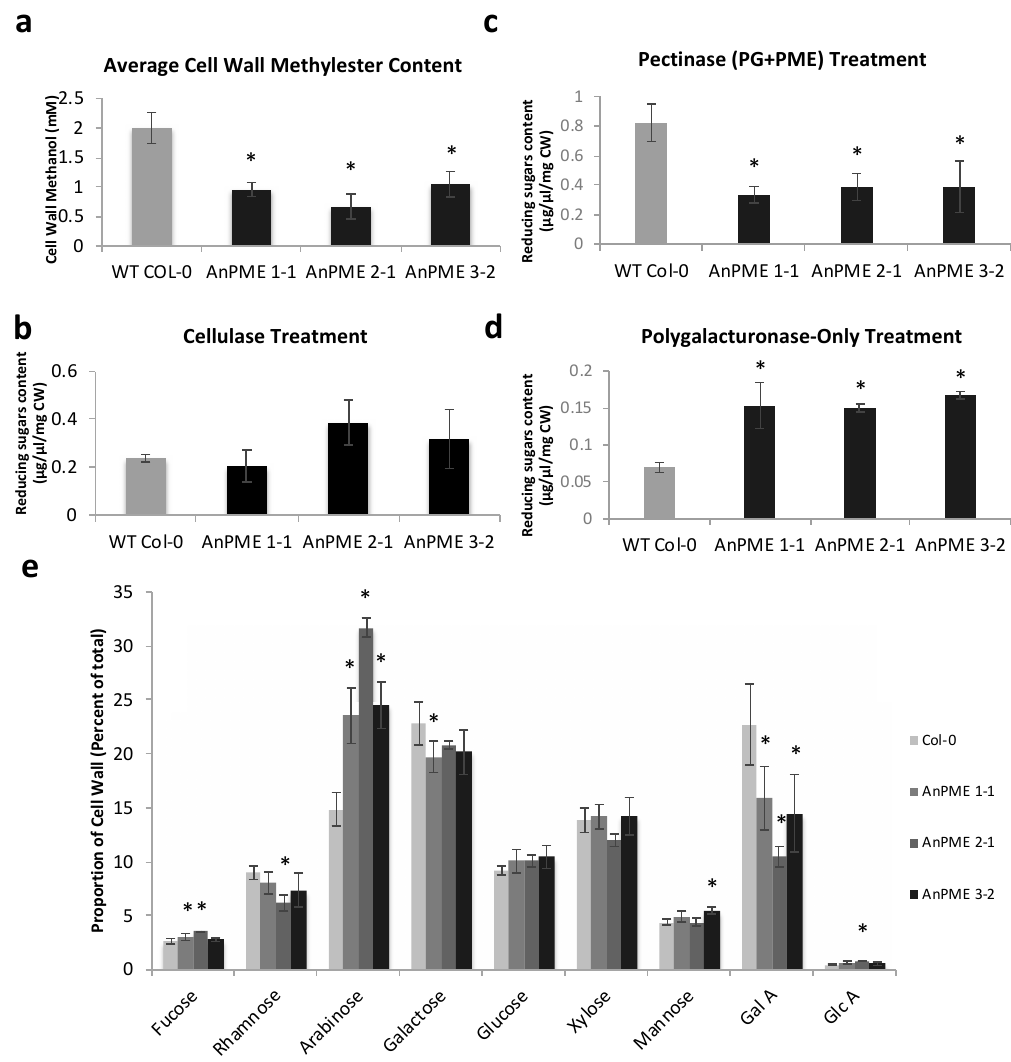
Figure 3. CW characterization and comparison between Col-0 and AnPME. ( a ) Methylester content in WT Col-0 and AnPME cell walls; ( b ) Amount of reducing sugars released into solution after treatment of cell wall with cellulase / cellobiase solution; ( c ) Amount of reducing sugars released into solution after treatment of cell wall with polygalacturonase / pectin methylesterase solution; ( d ) Amount of reducing sugars released into solution after treatment of cell wall with polygalacturonase; ( e ) Monosaccharide composition of cell walls. Error bars represent standard deviation. Asterisks indicate statistical significance ( p < 0.05, one-way ANOVA; n = 3 biological replicates of 10 pooled plants each).